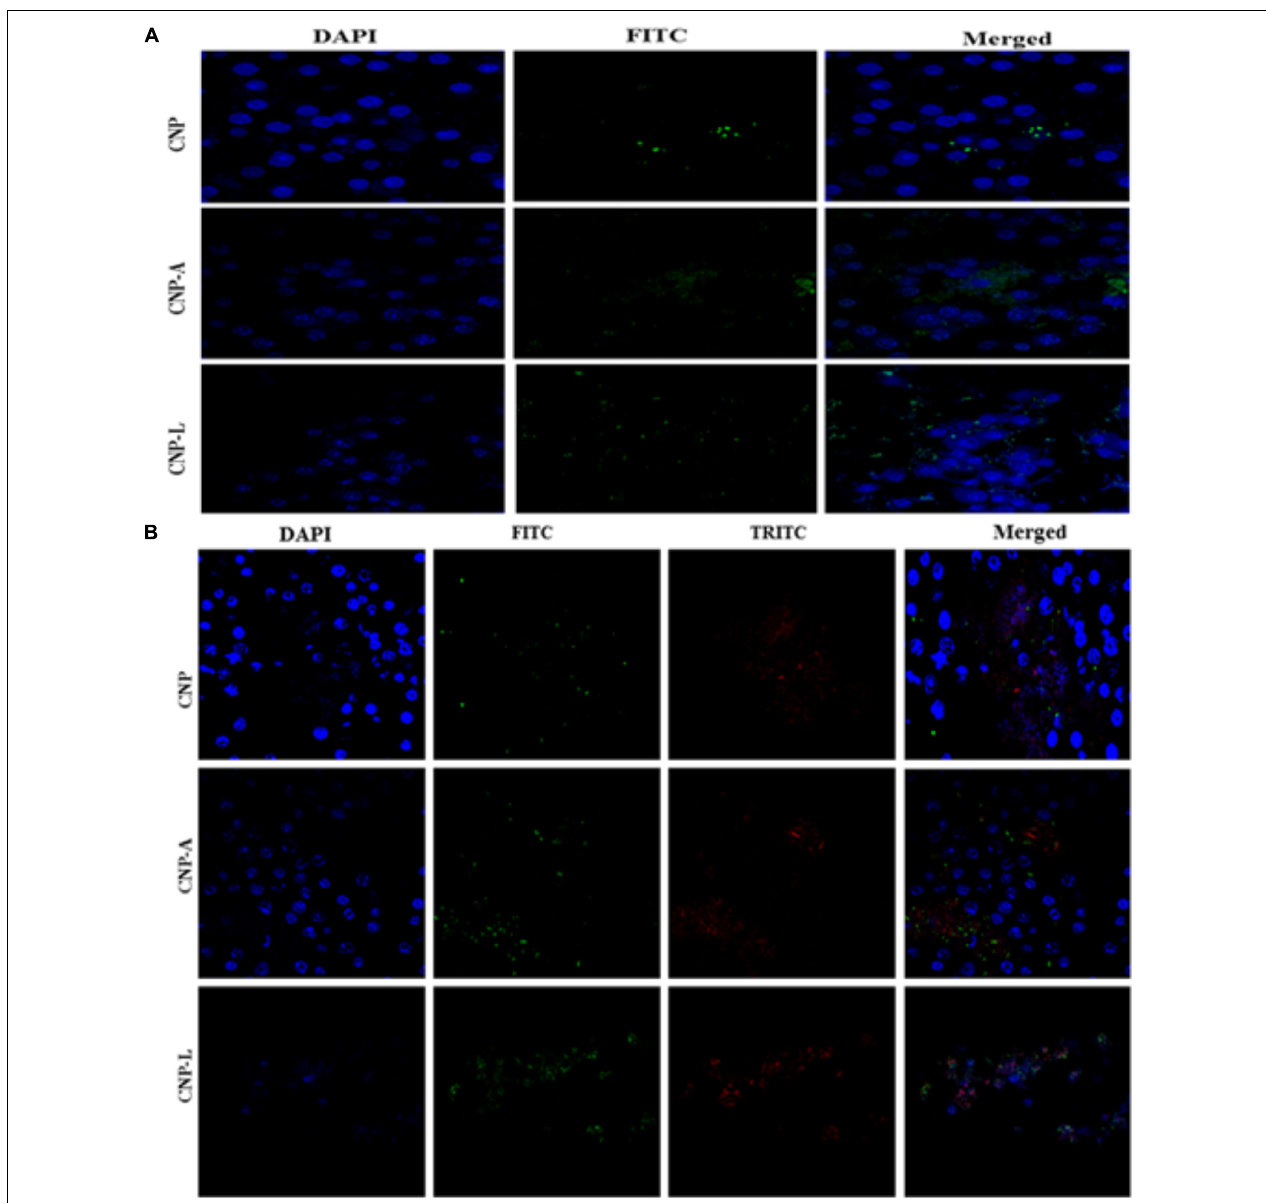
FIGURE 7 | Confocal microscope image showing cellular uptake capacity of ligand conjugated chitosan nanoparticles by RAW264.7 mouse macrophages cell line: macrophage cells were treated with equal concentration of CNP, CNP-A, and CNP-L NPs for 4 h and checked for co-localization of NP in cells. (A) Low uptake of various as-synthesized various CNPs was observed in uninfected RAW macrophages (B) while M. smegmatis infected RAW cells were more susceptible to engulf CNP-L as compared to both CNP and CNP-A nanoparticle. Staining is as follows: blue–DAPI–stained nuclei, green–FITC labeled CNPs, and red–TRITC labeled M. smegmatis cells. Post 4 h incubation, more no of CNP-L was seen inside the cytoplasm as compared to CNP-A and CNP. Scale bar shows 10 µ m. Pearson’s coefficients were calculated and expressed as mean value ± SD for at least three images obtained in three independent